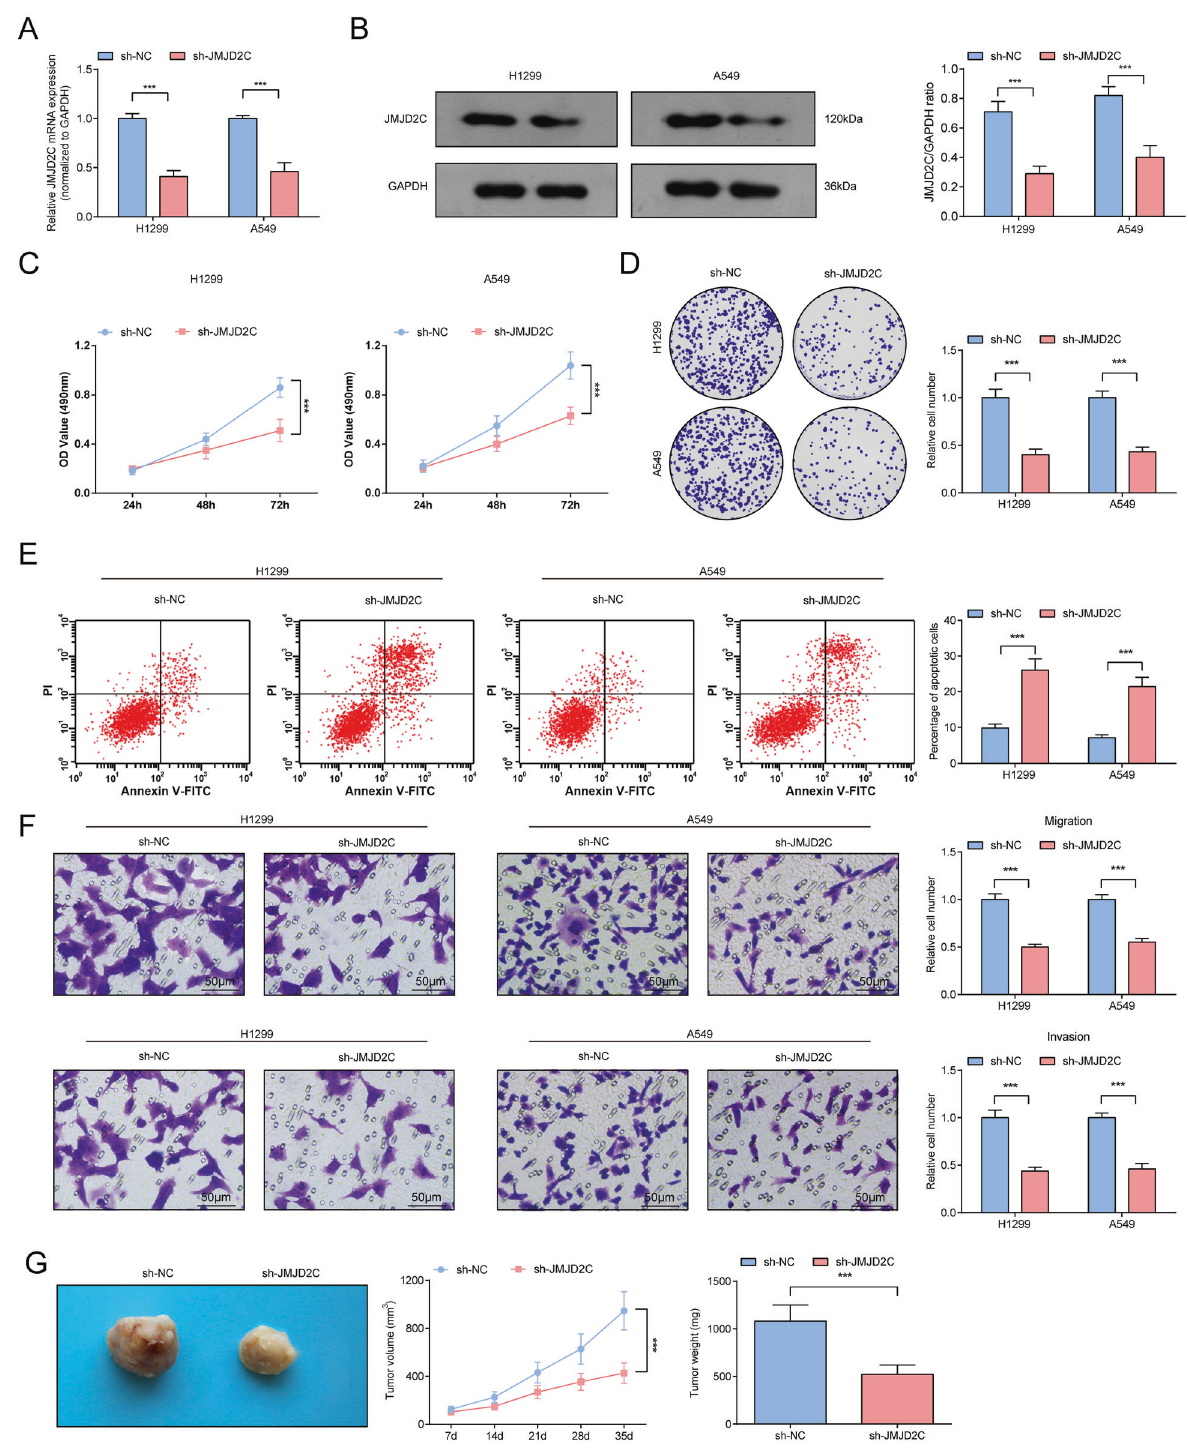
Fig. 2 Preventive effects of silenced JMJD2C on NSCLC. A , B RT-qPCR and Western blot analysis of JMJD2C level after downregulating JMJD2C; C MTT measured the growth curve of A549 and H1299 cells after downregulating JMJD2C; D Colony formation assay measured colony formation ability of A549 and H1299 cells after downregulating JMJD2C; E Flow cytometry measured A549 and H1299 cell apoptosis after downregulating JMJD2C; F Transwell measured cell migration and invasion ability after downregulating JMJD2C; G Tumor formation assay evaluated tumor volume and weight after downregulating JMJD2C. *** P < 0.001; Data statistics was by t -test.